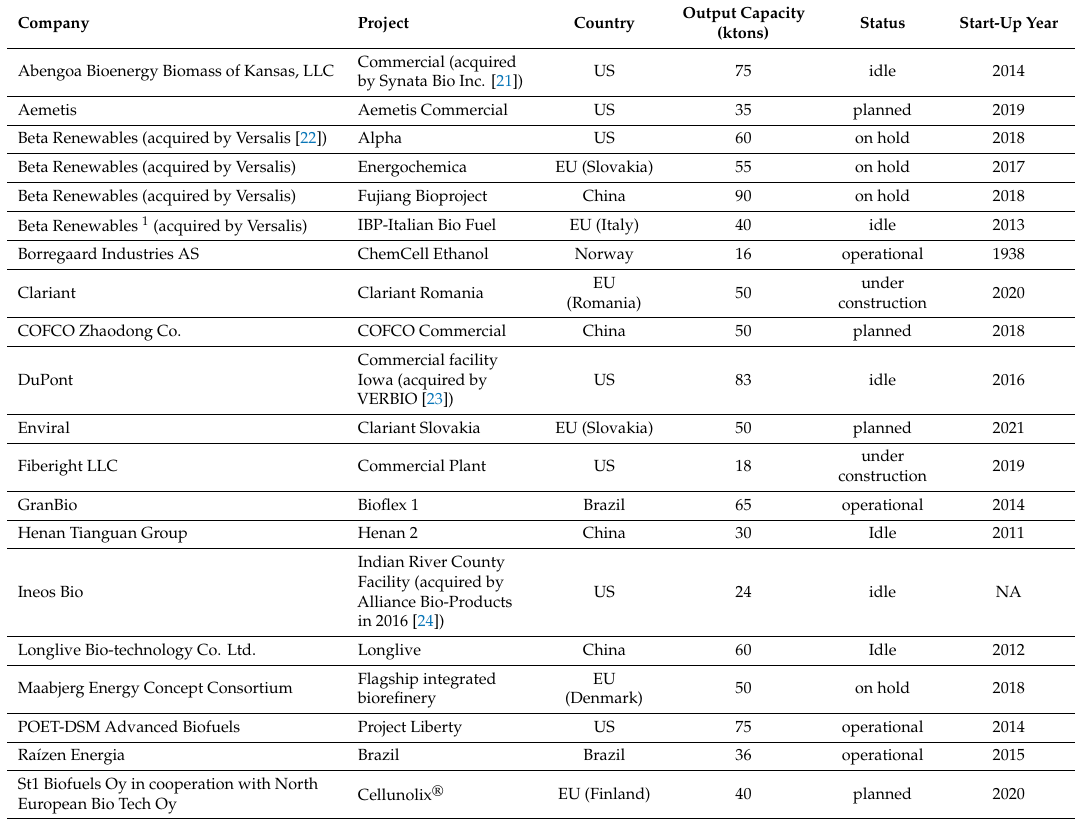
Table 1. Overview on a global commercial scale cellulosic ethanol